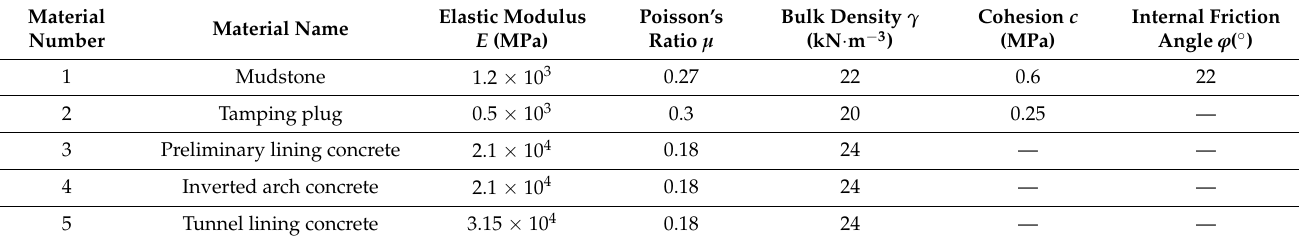
Table 3. Numerical parameters of surrounding rock and tunnel support structure.